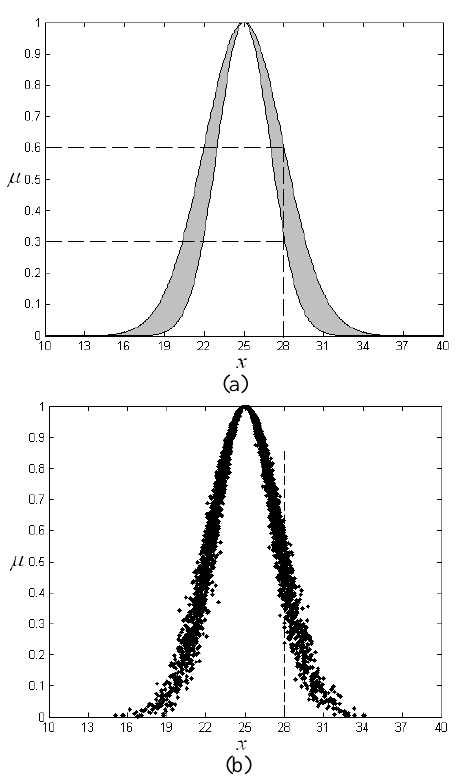
Fig. 1. Comparison on the theory basic of selected methods: (a) Interval type-2 fuzzy sets; (b) Normal loud